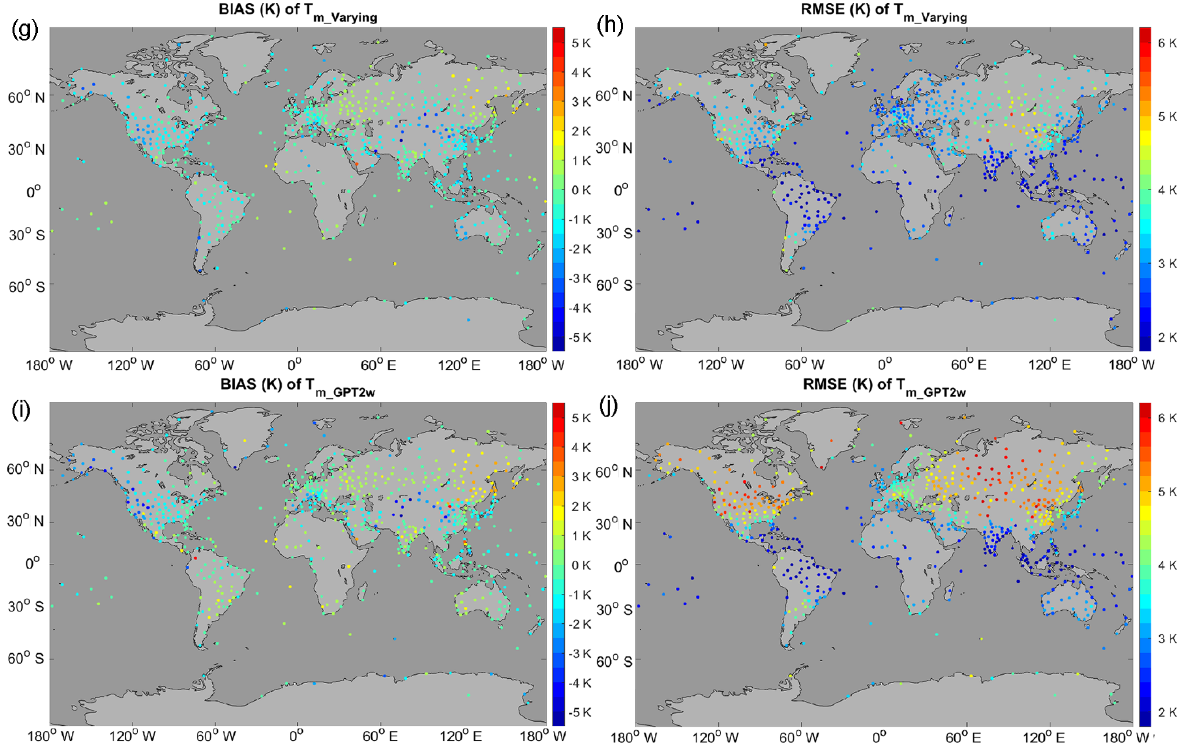
Figure 6. (a, c, e, g, i) The biases and (b, d, f, h, j) the RMSEs of the estimated T m from (a, b) the Bevis equation, (c, d) the latitude-related model, (e, f) our static global gridded model, (g, h) our time-varying global gridded model and (i, j) the GPT2w model at each radiosonde station. Reference data are the radiosonde data of the year 2016. Temperature unit is Kelvin.